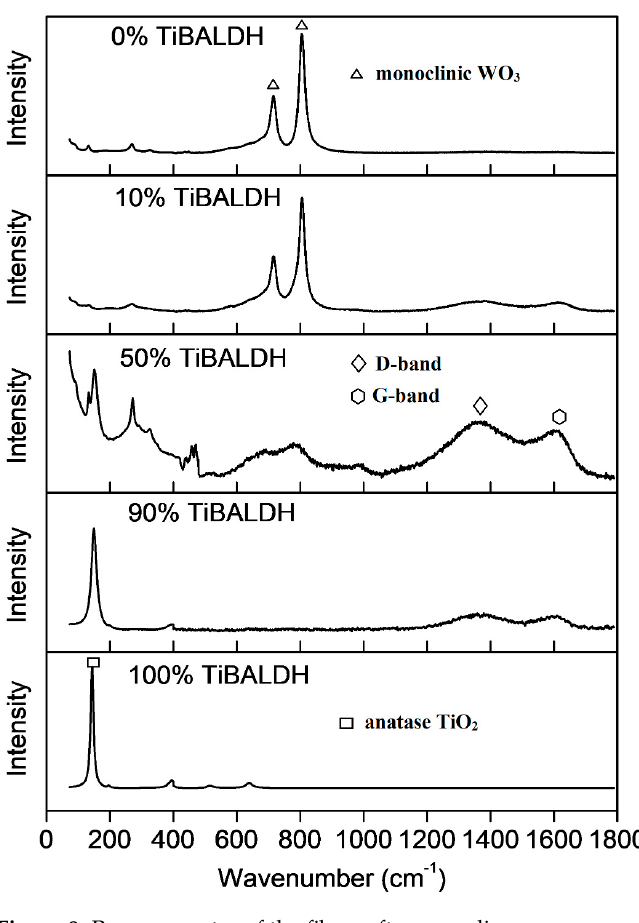
Figure 8. Raman spectra of the fibers after annealing.